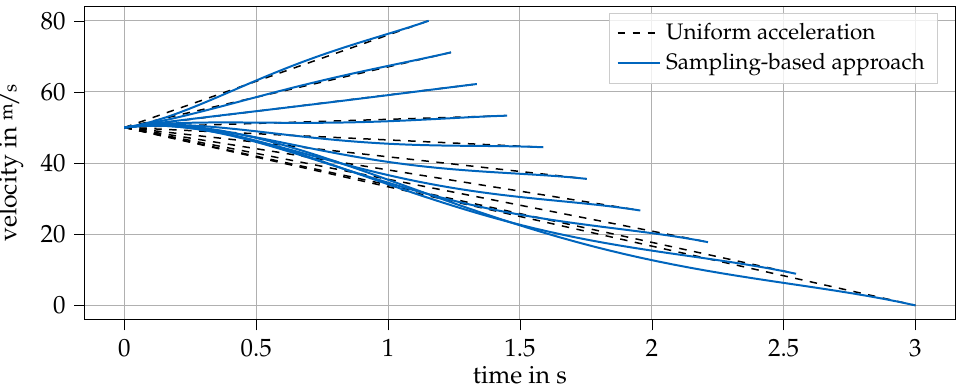
Figure 6. Comparison of velocity profiles generated by our sampling-based approach and uniform acceleration. Exemplarily, several end velocities from 0 to 80 m/s are sampled with a start velocity of 50 m/s and a start acceleration of 10 m/s